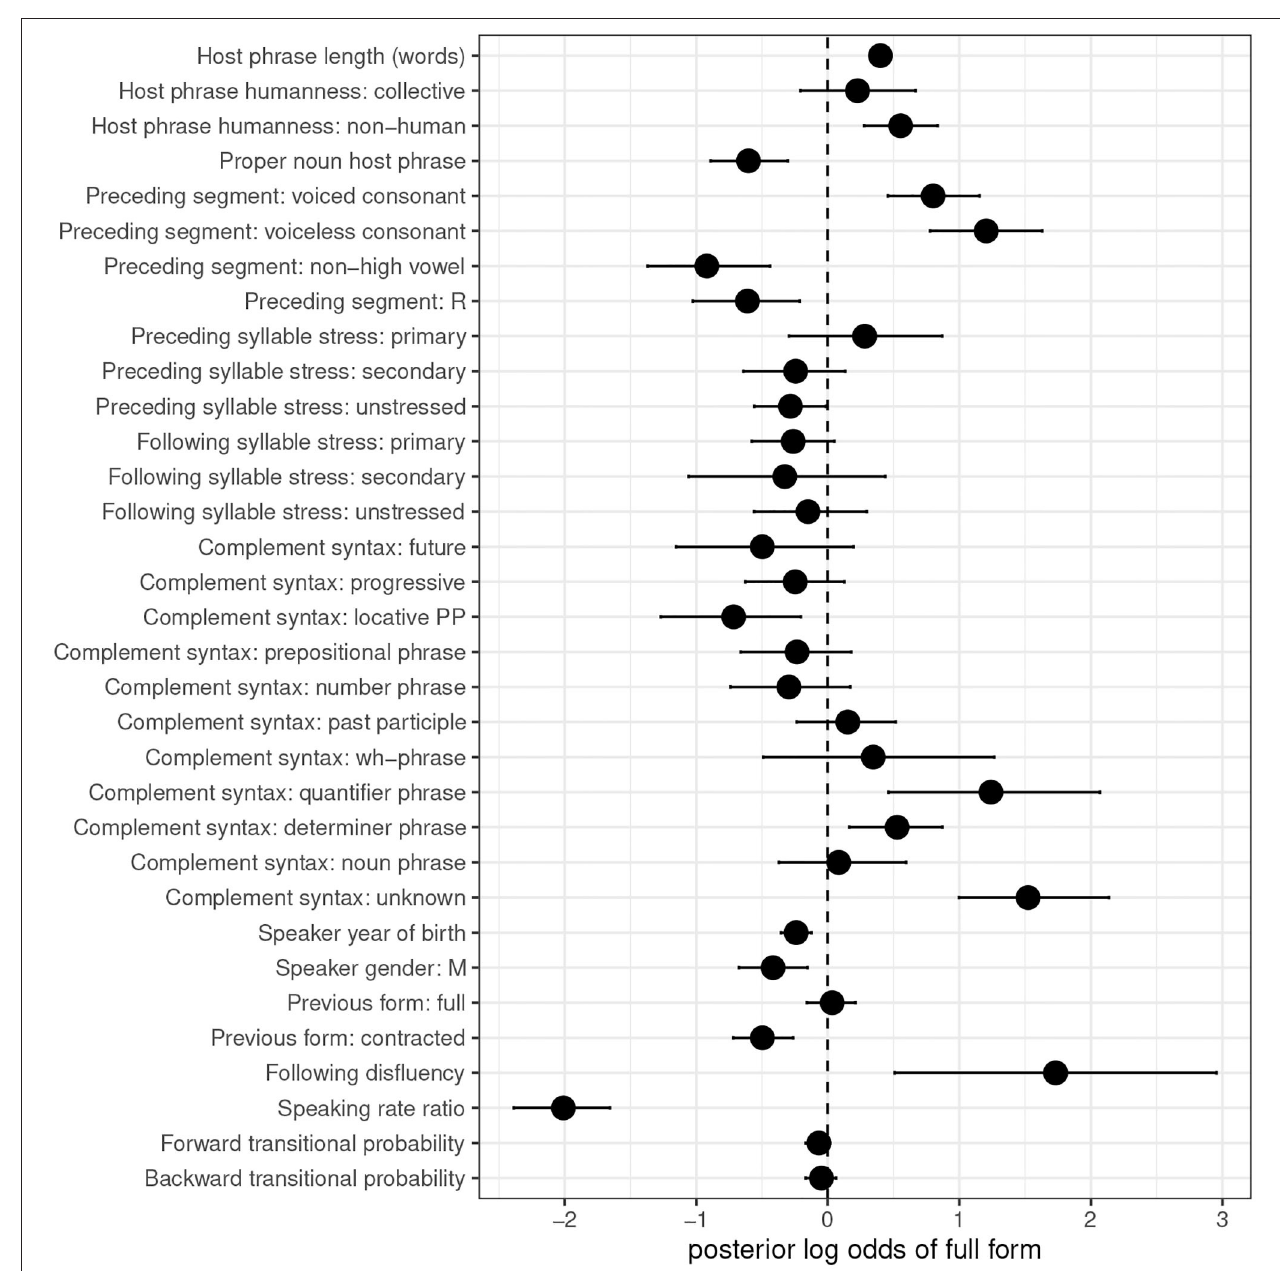
FIGURE 2 | Posterior means and 95% credible intervals for fixed effect predictors, is . Default level of dependent variable: contracted form. Points represent posterior log odds of the given predictor on use of the full